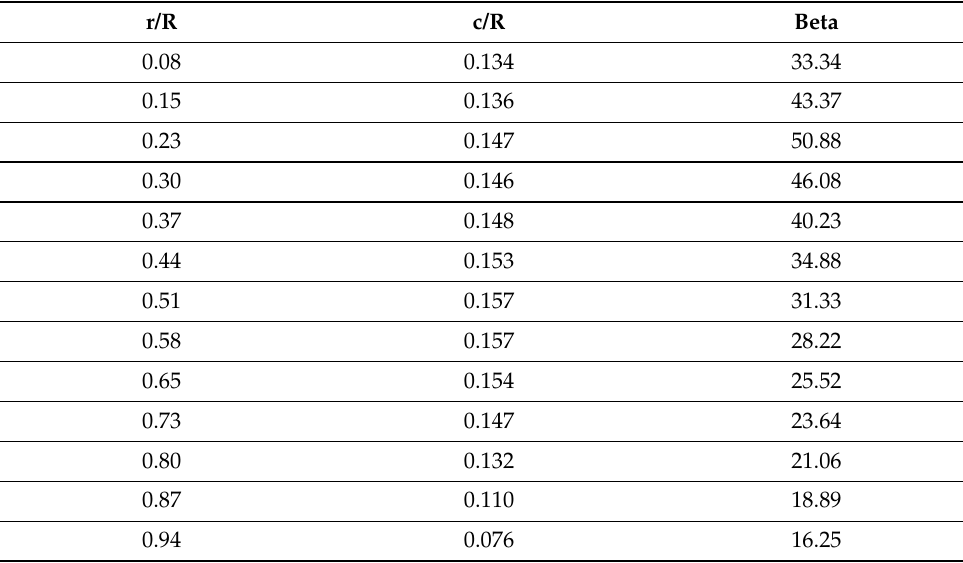
Table A1. APC 14 × 12 propeller